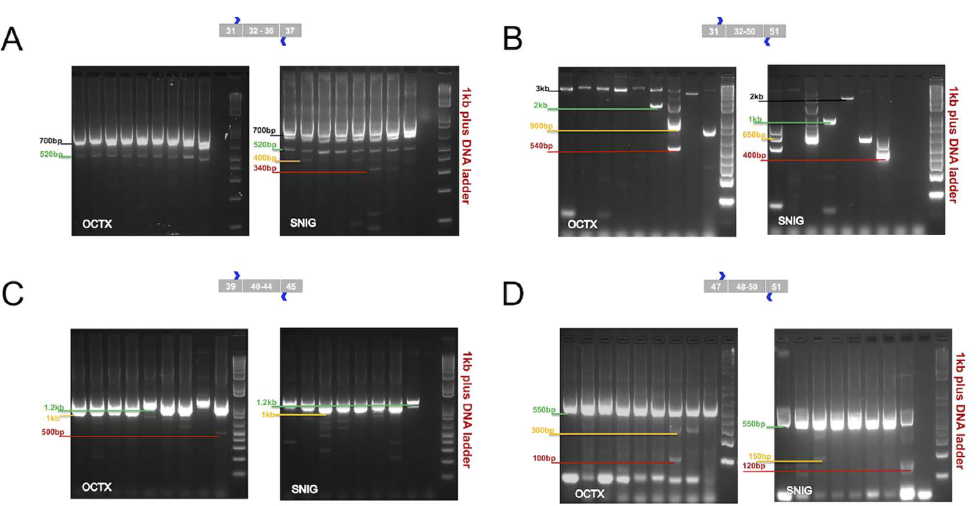
Figure 2. ( A ) RT-PCR results confirming differential splicing in targeted region (exon 32–36) corresponding to functional ROC-COR domains in LRRK2 gene in occipital cortex (OCTX) and substantia nigra (SN) (SNIG). It is clear the two regions have different patterns from same nine individuals for OCTX and eight individuals for SN. The expected band for this primer pair is ~870 bp, in OCTX 2 bands at ~520 and 700 bp are shown. In SN more bands are shown, one at 340, 400, 520 and 700 bp; ( B ) RT-PCR results confirming differential splicing in targeted region (exons 32–50), corresponding to the functional COR-KIN-WD40 domains in LRRK2 gene in OCTX and SN. The expected band for this primer pair is ~3 kb, in OCTX the expected band is shown, in addition to other bands ~540, 900 and 2 kb. SN has different bands, at 400, 650, 1 kb, 2 kb and more; ( C ) RT-PCR results confirming differential splicing in targeted region (exons 40–44). It is corresponding to the kinase domain in the LRRK2 gene in OCTX and SN. The expected band for this primer pair is ~1 kb, in OCTX the expected band is shown, in addition to other bands ~500 and 1.2 kb. SN has similar bands, at 500, 1 kb (expected band), 1.2 kb and more; ( D ) RT-PCR results confirming differential splicing in targeted region (exons 48–50). It is corresponding to the WD40/C-terminus domains in the LRRK2 gene in OCTX and SN. The expected band for this primer pair is ~550 bp, in OCTX the expected band is shown, in addition to other bands ~100 and 300 bp. SN has similar bands, at 120, 150 and 550 bp (expected band) and